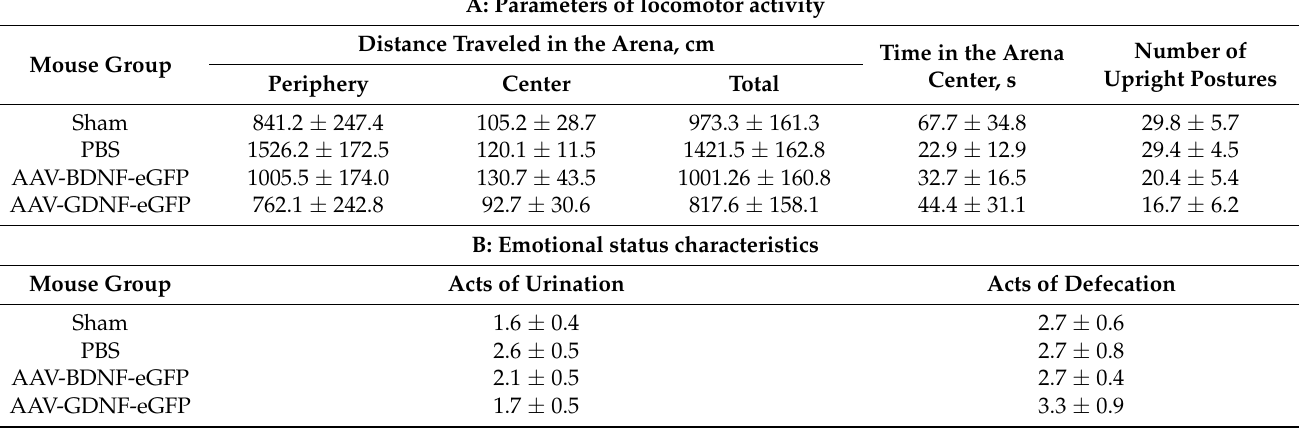
Table 1. Parameters of behavioral reactions of mice in the Open Field test after the provocation of audiogenic seizures. A: Parameters of locomotor activity